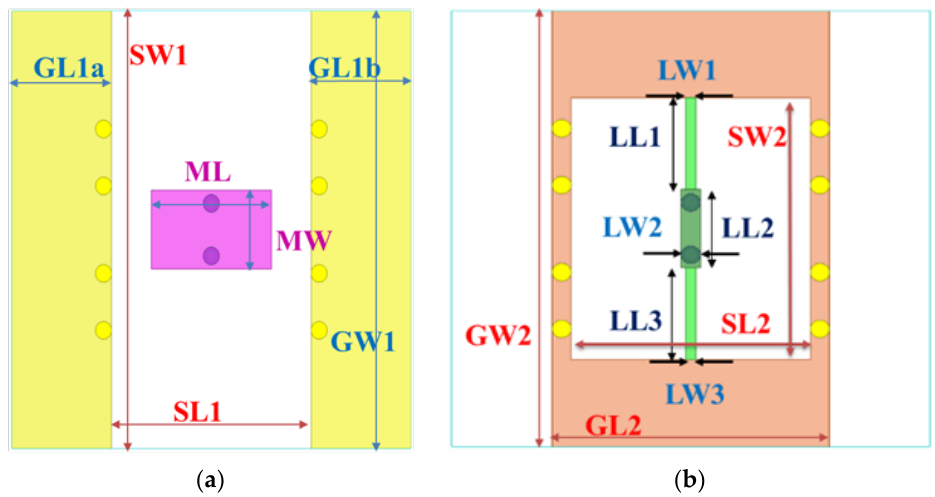
Figure 2. The proposed MDCRP structure filter. ( a ) The first ground plane. ( b ) The second ground plane.